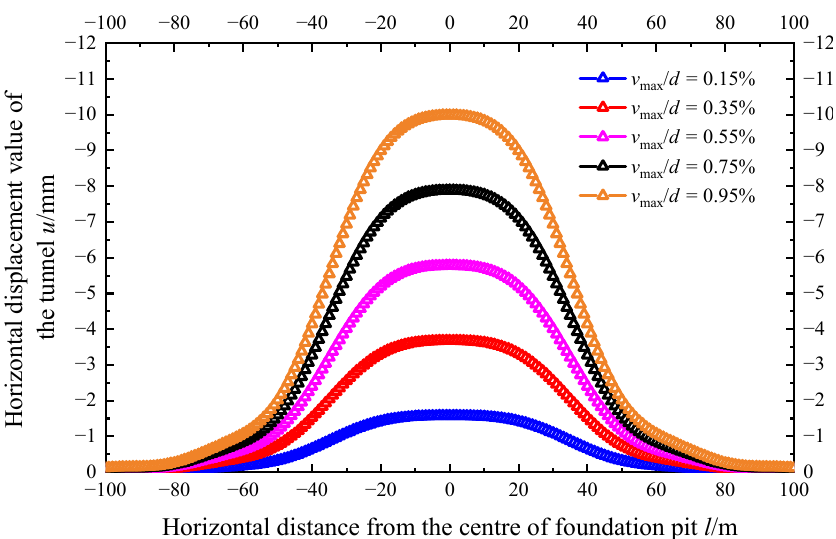
Figure 15. The longitudinal distribution curve of the adjacent tunnel’s horizontal displacement when v max / d uses different values.